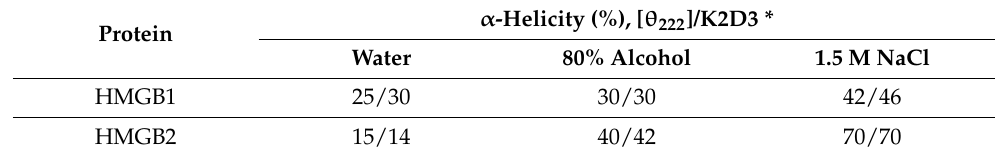
Table 1. α -helicity (%) for HMGB1 and HMGB2 proteins in different solutions.